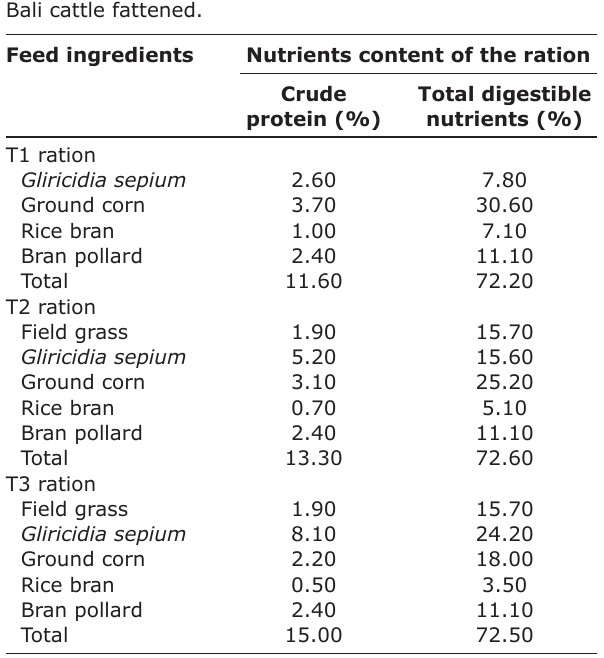
Table-3: Formulation of complete ration of research for Bali cattle fattened. Feed